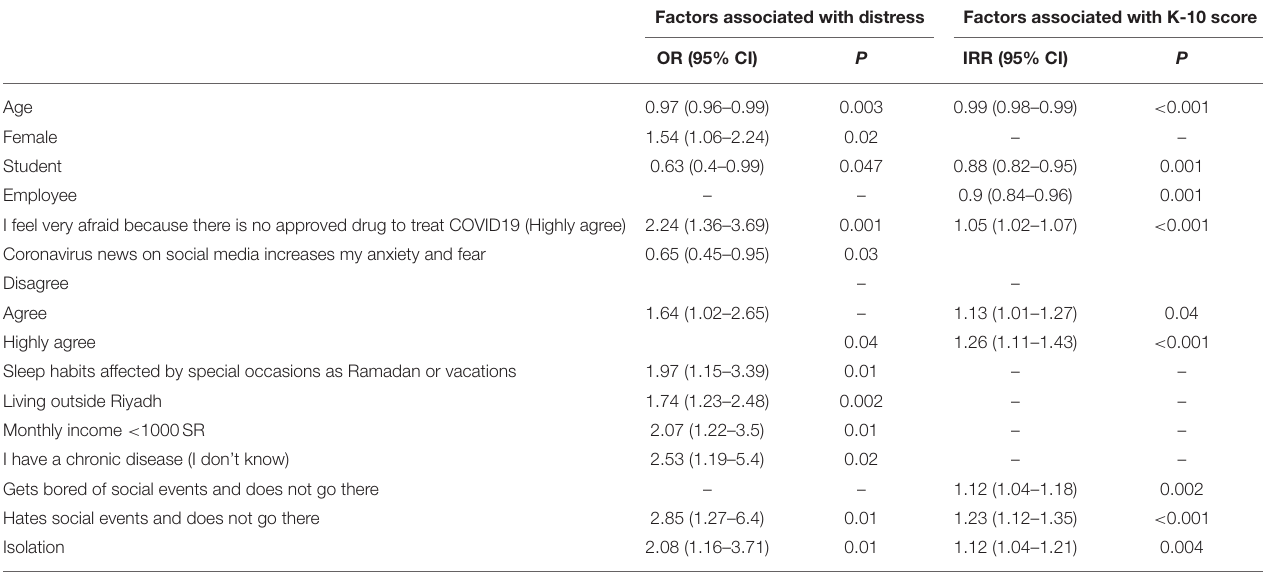
TABLE 4 | Factors associated with distress and K-10